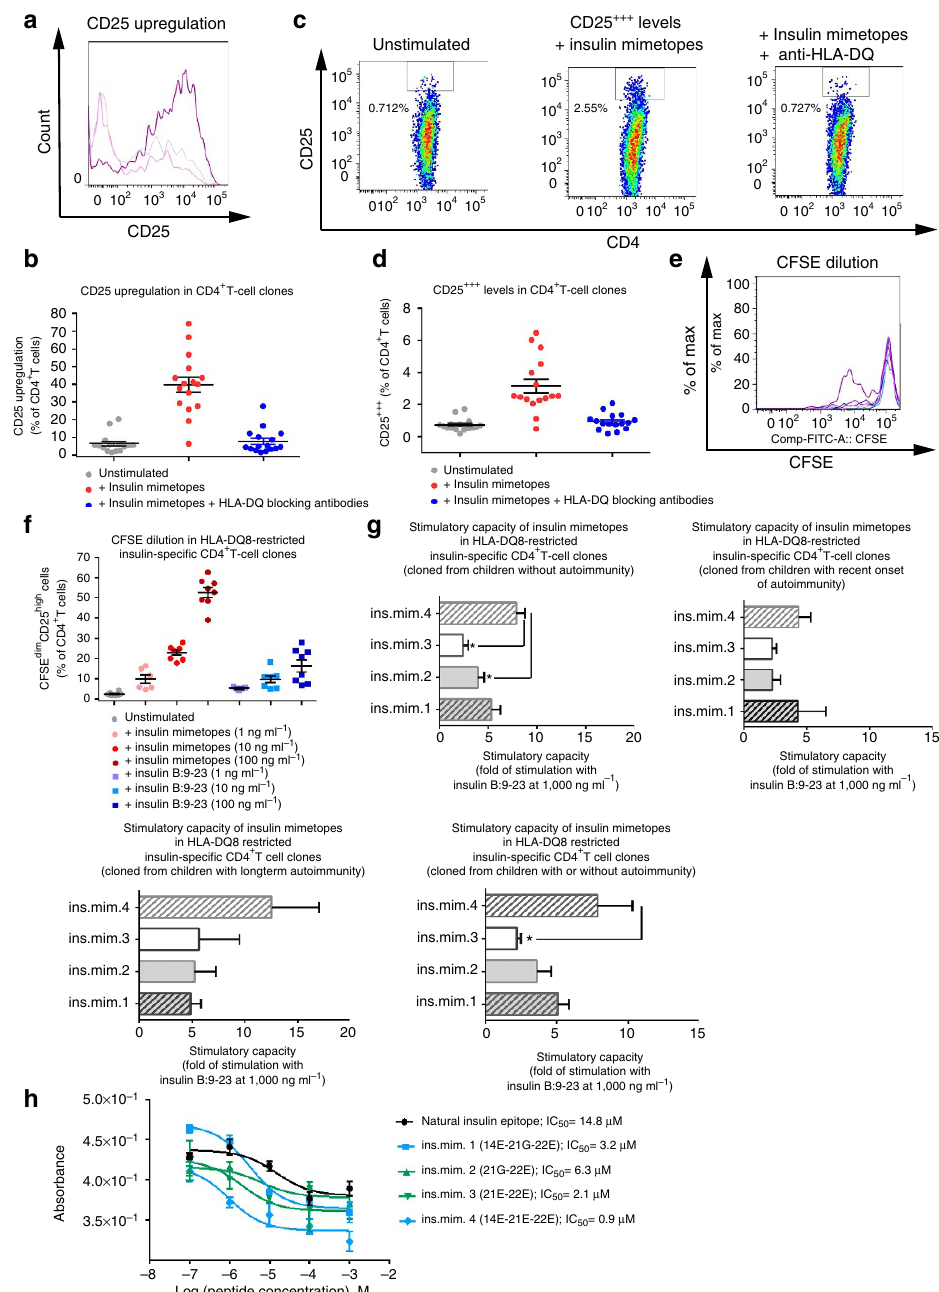
Figure 4 | Agonistic activity of insulin mimetopes in human insulin-specific CD4 þ T-cell clones. ( a ) CD25 upregulation in CD4 þ T-cell clones left untreated or upon stimulation with insulin mimetopes (ins.mim.1,2,3,4 at 100ngml (cid:3) 1 ) with or without DQ-blocking antibodies (grey line: unstimulated control; dark pink line: þ insulin mimetopes; light pink line: þ insulin mimetopes þ HLA-DQ blocking antibodies). ( b ) Summary graph for a . 16 CD4 þ T-cell clones: four from three subjects without ongoing autoimmunity; five from four subjects with recent onset of autoimmunity, seven from five individuals with long-term autoimmunity. ( c ) CD25 þ þ þ levels of an insulin-specific CD4 þ T-cell clone left unstimulated (left plot), stimulated with insulin mimetopes (middle plot) or with insulin mimetopes þ HLA-DQ blocking antibodies (right plot). ( d ) Summary graph for c . Numbers of clones tested as in b . ( e ) CFSE- dilution profiles from insulin-specific CD4 þ T-cell clones (grey line: unstimulated; light blue: þ insulin B:9-23 epitope (1ngml (cid:3) 1 ); blue line: þ insulin B:9-23 epitope (10ngml (cid:3) 1 ); dark blue line: þ insulin B:9-23 epitope (100ngml (cid:3) 1 ); light pink line: þ insulin mimetopes (1ngml (cid:3) 1 ); pink line: þ insulin mimetopes (10ngml (cid:3) 1 ); dark pink line: þ insulin mimetopes (100ngml (cid:3) 1 )). ( f ) Summary graph for e . Eight CD4 þ T-cell clones have been tested: two from two subjects without ongoing islet autoimmunity, two from two individuals with recent onset of autoimmunity, four from three individuals with long-term autoimmunity. ( g ) Summary graphs of stimulatory capacities of ins.mim.2 ¼ 21G-22E; ins.mim.3 ¼ 21E-22E; ins.mim.1 ¼ 14E-21G-22E; ins.mim.4 ¼ 14E-21E- 22E (100ngml (cid:3) 1 ) in T-cell clones shown in fold of the stimulatory potential of the insulin B:9-23 (1,000ngml (cid:3) 1 ). Numbers of clones tested as in b . ( b , d , f , g ) Data represent the means ± s.e.m. 16 clones ( b , d , g ) or eight clones ( f ) have been tested. * P o 0.05 (Student´s t -test). ( h ) In vitro binding of insulin B:9-23, ins.mim.1 (14E-21G-22E), ins.mim.2 (21G-22E), ins.mim.3 (21E-22E) and ins.mim.4 (14E-21E-22E) to HLA-DQ8. Competitive binding assays were carried out using a FITC-labelled reference GAD65 peptide and increasing concentrations of unlabelled insulin epitopes and